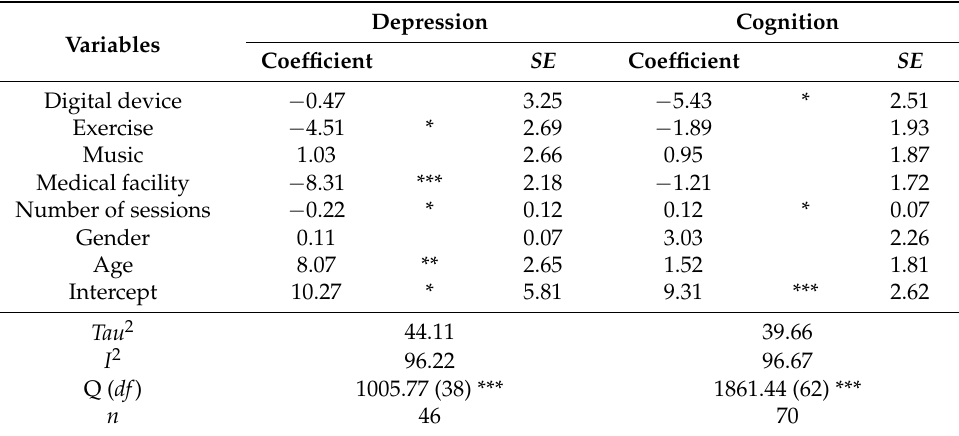
Table 3. Meta-regression analysis for evaluating the effect sizes of digital device programs, exercise programs, and music programs on depression and